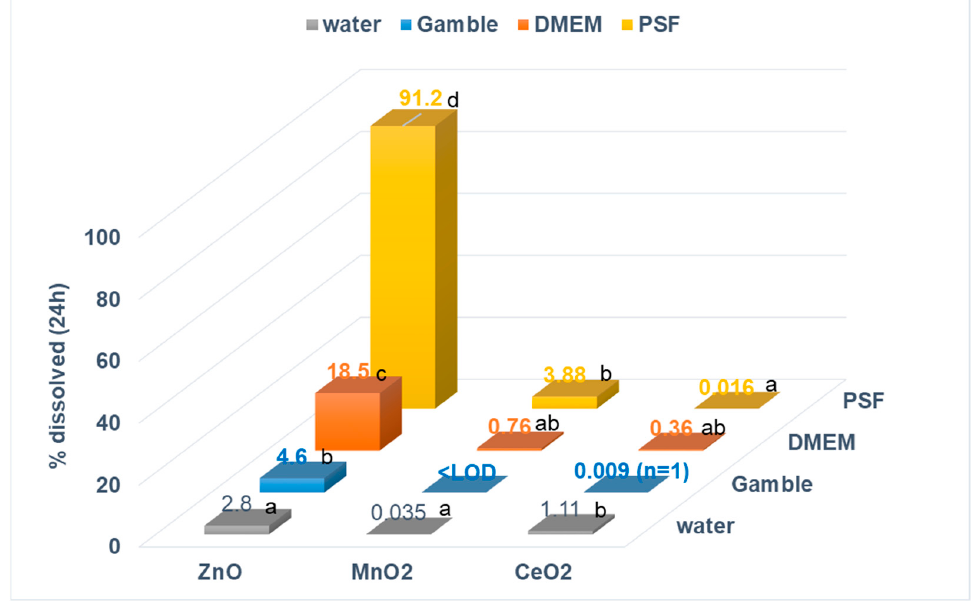
Figure 3. Influence of aqueous medium on % solubility of nano metal-oxides at a 100 mg/L initial concentration (<LOD = below the limit of detection). Extraction time was 24 h (grey, water; blue, Gamble; red, DMEM; yellow, PSF), and pH = 4.5 for PFS, 7.4 for DMEM and Gamble, and 7.8, 6.3, and 4.6 for ZnO, MnO 2 , and CeO 2 , respectively, in water. For a given metal-oxide, values followed by the same letter are not statistically different at α = 0.05. See Table S8 for standard deviations and Table S9B for results of statistical tests.